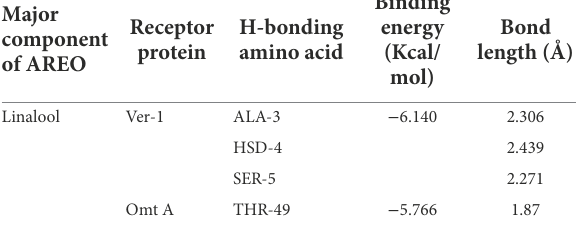
TABLE 5 Binding energy and bond length of linalool (major component of AREO) with Ver-1 and Omt A protein. Major Receptor component of AREO